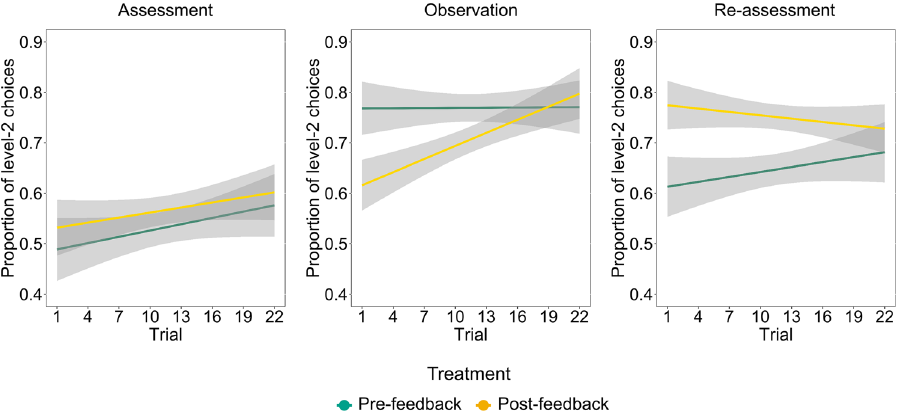
Figure 3. Temporal evolution of strategic sophistication across phases in the Medium-sophistication cluster. We characterize the learning process of participants in the Medium-sophistication cluster, in which we observed an effect of social learning, by plotting the temporal evolution of the proportion of level-2 choices in Pre- feedback and Post-feedback treatments. Trial, ordered by time of presentation, has been used as time variable. Grey bounds represent standard errors. Data has been smoothed by linear fit. Results reveal a significant dynamic learning effect along the Observation phase for participants in the Post-feedback treatment, but not for participants in the Pre-feedback